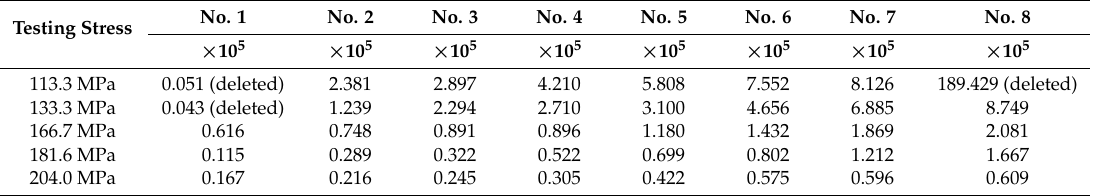
Table 2. Fatigue lives for 7075-T7351 Al alloy under different stress amplitudes in air.